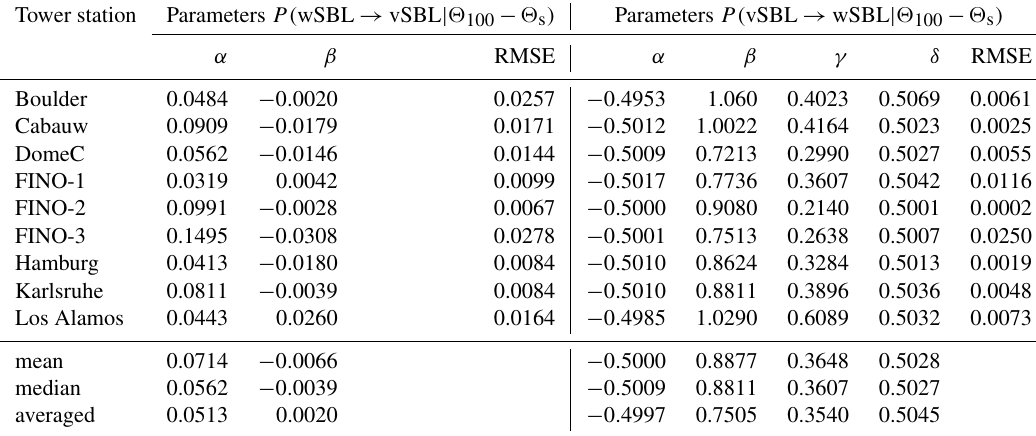
Table 4. Parameter values for the state-dependent parametric probability transition functions conditioned on stratification ( (cid:50) 100 − (cid:50) s , (cid:50) 4 − (cid:50) s , and (cid:50) 100 − (cid:50) 30 for, respectively, land-, glacial-, and sea-based sites) and the RMSE between parameterized values and those obtained from estimations of HMM analyses. The mean and median values of the parameters are stated below together with the best-fit approximation through all data